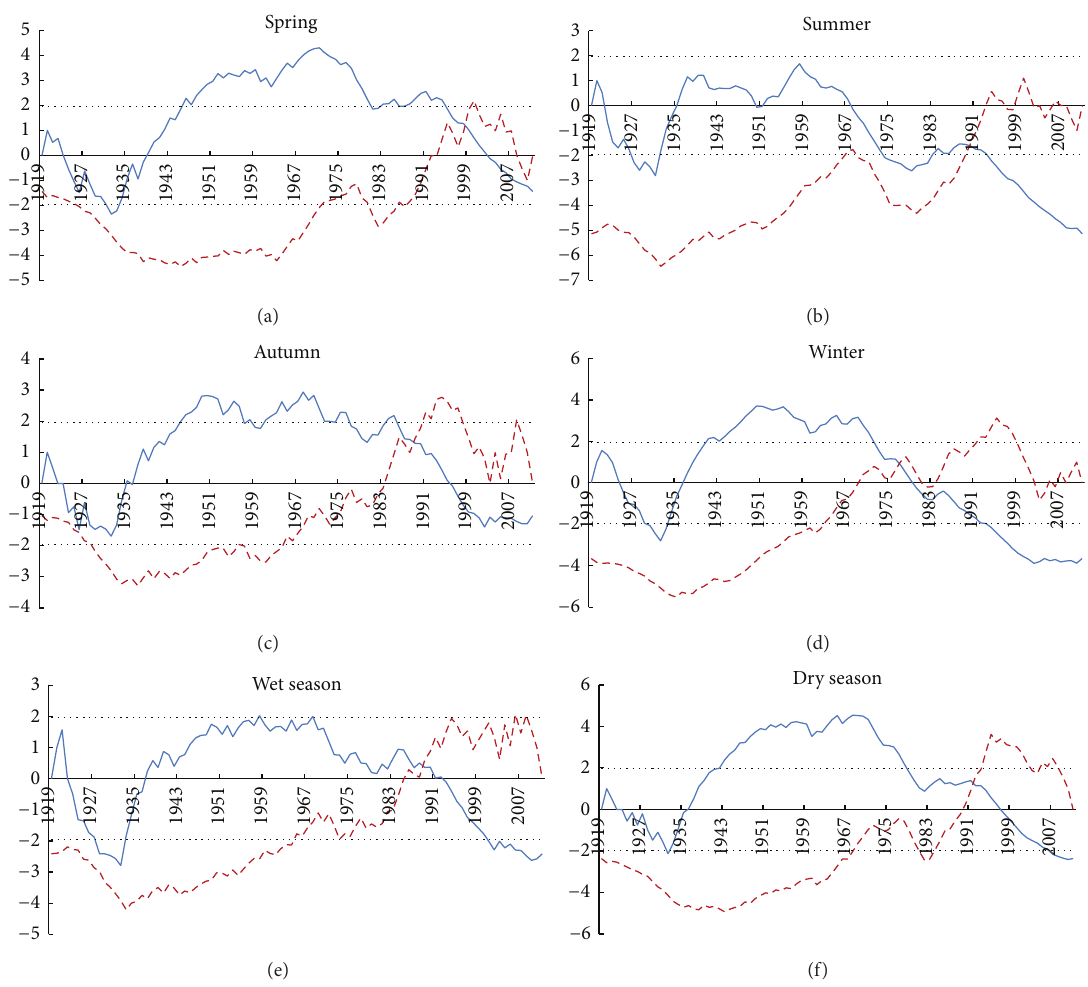
Figure 5: Mann-Kendall test statistics ( 𝑈𝐹 and 𝑈𝐵 values) calculated from seasonal runoff data at the Huaxian station.